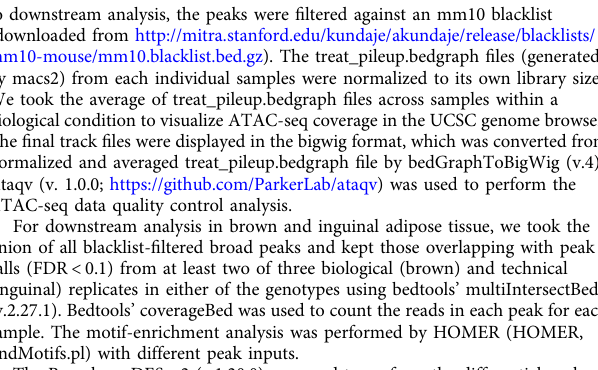
Fig. 7 BAF60a de fi ciency triggers ACTH/MC2R signaling to promote browning. a qPCR analysis of gene expression in beige adipocytes transduced with adeno-associated viruses (AAVs) expressing GFP (gray) or MC2R (orange). Cells were treated with 0, 0.3, and 1 nM ACTH for 5 h ( n = 4 per group). Data represent mean ± s.d. ACTH vs. Veh, two-tailed unpaired Student ’ s t test. b Immunoblots of beige adipocytes transduced with AAV-GFP ( − ) or AAV- MC2R ( + ) following treatments with ACTH (0.06 or 3 nM), isoproterenol (Iso, 20 nM), or forskolin (FSK, 5 μ M) for 15 min ( n = 2 per group). c qPCR analysis of gene expression in beige adipocytes transduced with scramble (Ctrl, open) or shMc2r (blue) AAV vector. Differentiated adipocytes were treated with Veh or 10 nM ACTH for 5 h ( n = 4 per group). Data represent mean ± s.d. shMc2r vs. Ctrl, two-tailed unpaired Student ’ s t test. d Immunoblots of transduced beige adipocytes treated with Veh, 3 nM ACTH or 20 nM Iso for 15 min ( n = 2 per group). e Immunoblots of iWAT explant culture treated with Veh, 10 nM ACTH, or 30 nM Iso for 10 min. f qPCR analysis of iWAT gene expression from mice treated with Veh ( fl ox, n = 4; AKO, n = 4) or